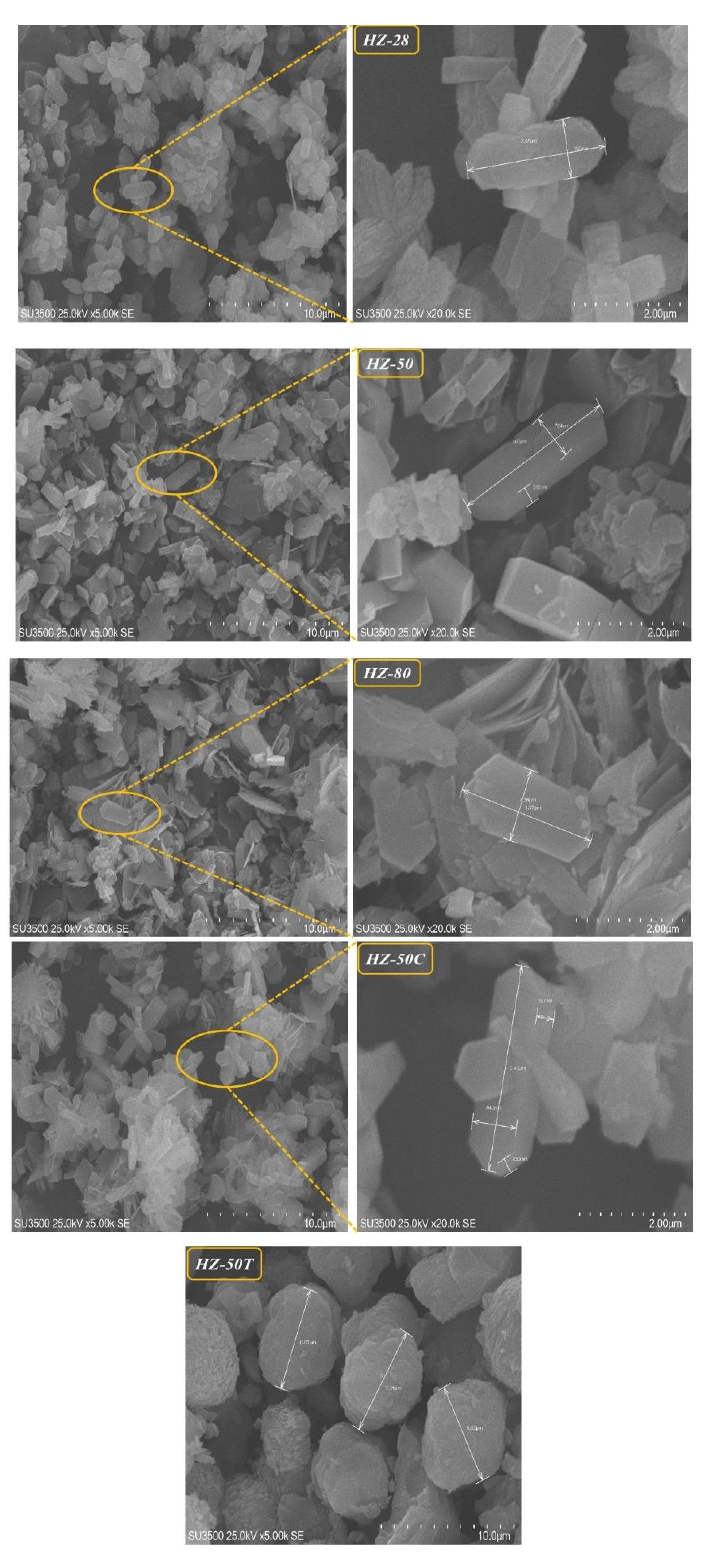
Fig. 4. SEM image of the samples after crystallization and calcination